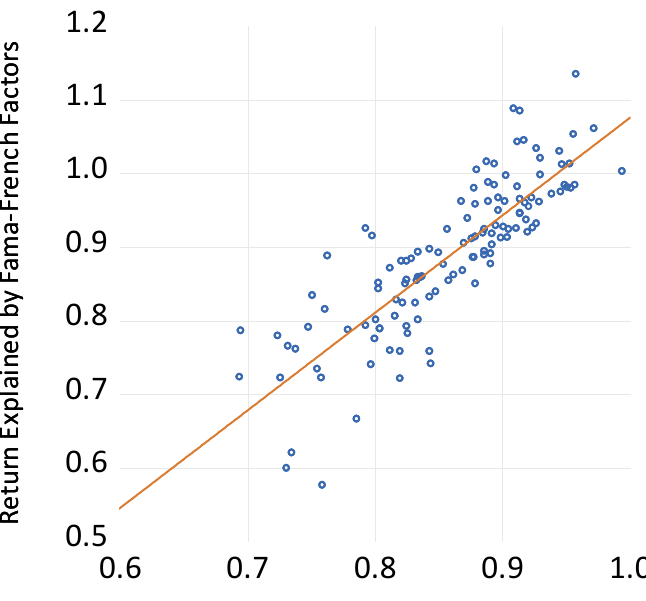
Figure 3. Values on 10 July 2020 of One Dollar Invested on 19 February 2020 Explained by Eight Macroeconomic Factors versus Corresponding Values Explained by Fama and French Factors. Note: The horizontal axis measures the values on 10 July 2020 across 125 sectors of a dollar invested on 19 February 2020 explained by 8 macroeconomic factors. These factors are (1) the return on the aggregate U.S. stock market index, (2) the return on the world stock market index, (3) the change in the Federal Reserve broad trade-weighted exchange rate index, (4) the change in the log of the spot price from West Texas Intermediate crude oil, (5) the change in the breakeven inflation rate calculated from U.S. Treasury inflation-protected securities, (6) the change in the interest rate on three-month Treasury securities, (7) the change in the spread between interest rates on ten-year and three-month Treasury security, and (8) the change in the spread between interest rates on Moody’s seasoned Baa corporate bonds and ten-year Treasury securities. The vertical axis plots the corresponding values explained by the five Fama and French (2015) factors. These factors are (1) the return on the aggregate U.S. stock market index minus the return on one-month Treasury securities, (2) the average return on nine small capitalization stock portfolios minus the average return on the nine large capitalization stock portfolios, (3) the average return on two high-book value to market value portfolios minus the average return on the two low-book value to market value portfolios, (4) the average return on two robust operating profitability portfolios minus the average return on two weak operating profitability portfolios, and (5) the average return on two conservative investment portfolios minus the average return on two aggressive investment portfolios. Source: Datastream database, Federal Reserve Bank of St. Louis FRED database, homepage of Professor Kenneth French, and calculations by the author.